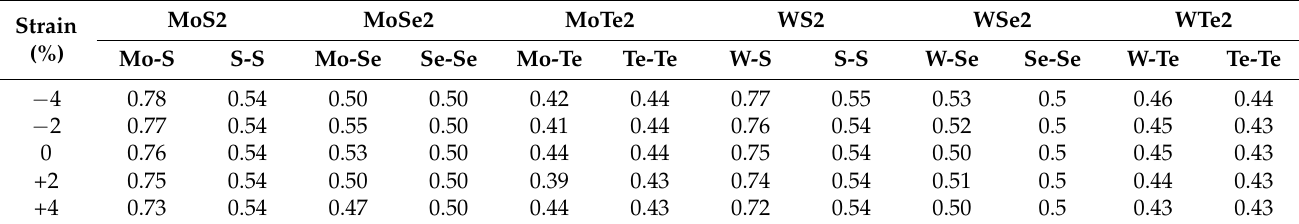
Table 1. G/ ρ values of M-X and X-X bonds in strained and unstrained MX2 (M = Mo, W; X = S, Se, Te) bilayers.